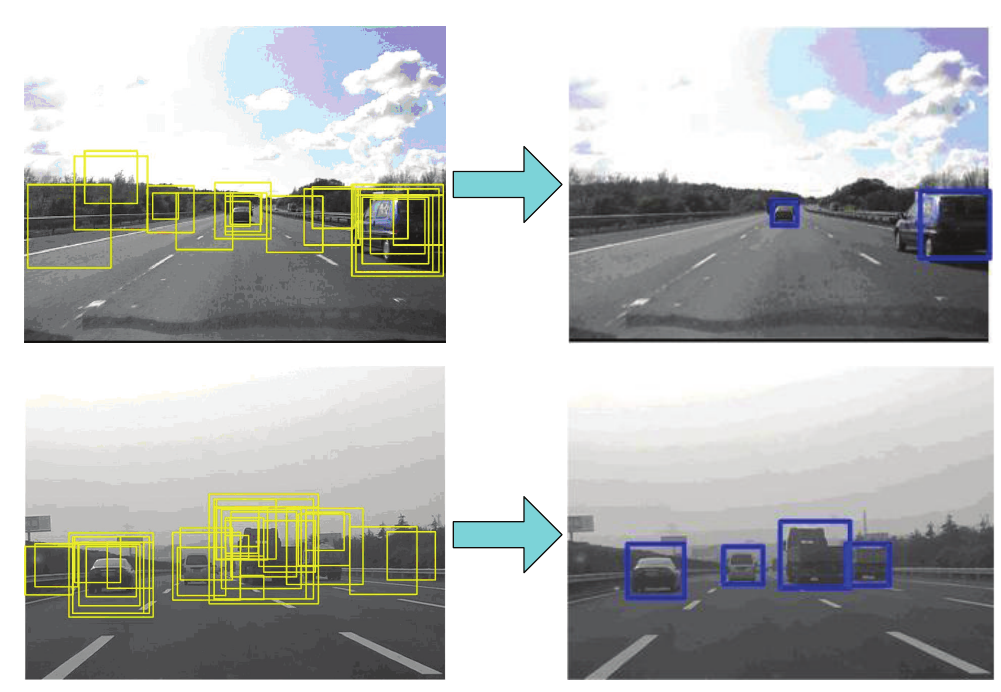
Figure 6: Vehicle candidate verification results.